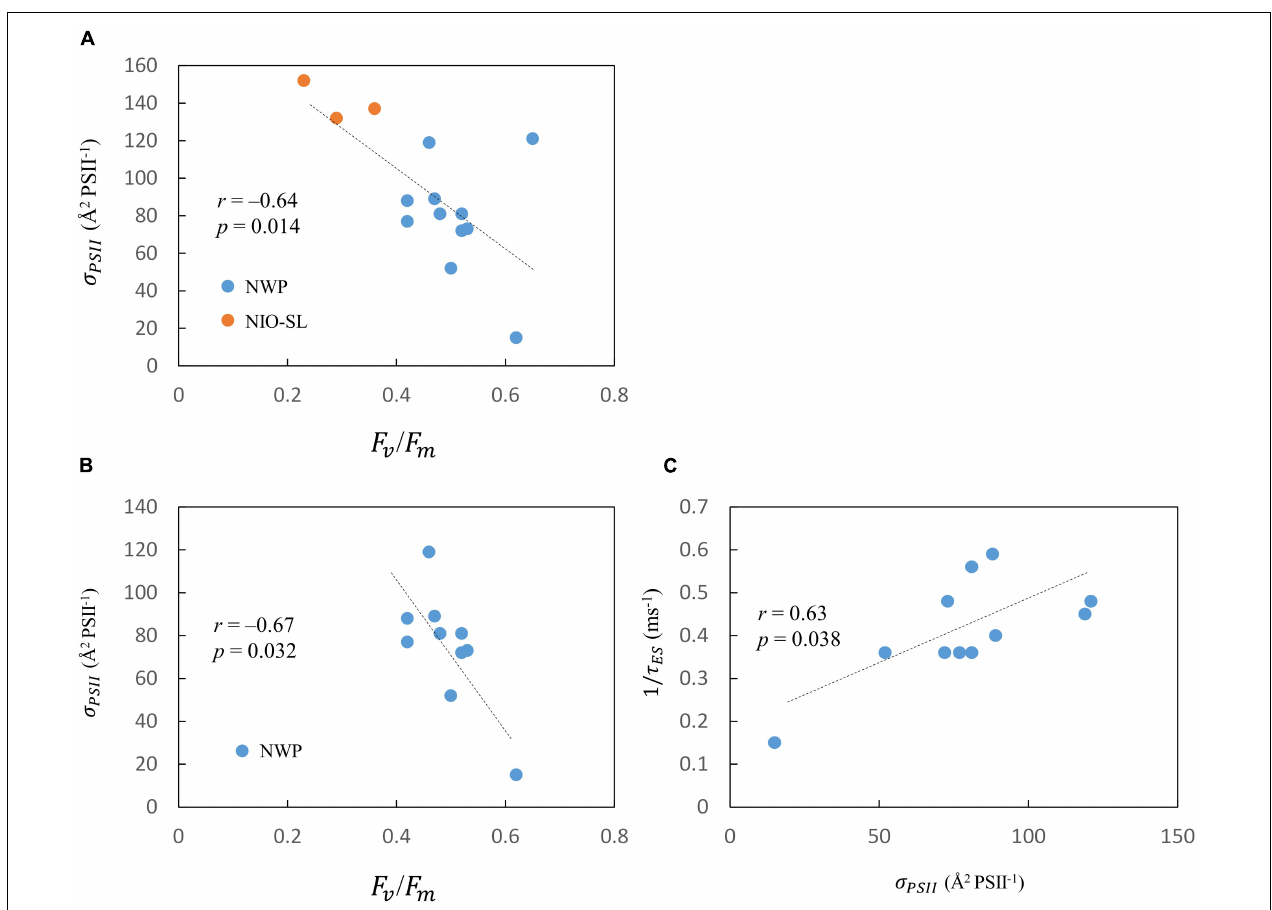
FIGURE 5 | Scatter plots of (A) PSII maximum photochemical efficiency, F v / F m , and functional absorption cross section of PSII, σ PSII (Å 2 PSII − 1 ) for pooled data. Scatter plots of (B) F v / F m and σ PSII (C) σ PSII and PSII turnover time 1 / τ ES for NWP data only.